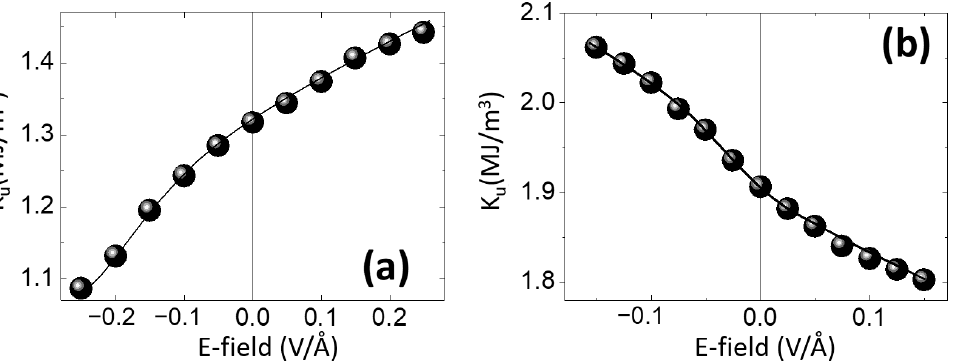
Figure 5. Opposite sign variation of the perpendicular magnetic anisotropy energy ( K u ) with an applied electric field (E-field) calculated for ( a ) V/Fe(5ML)/MgO and ( b ) Au/Fe(5ML)/MgO supercells- (adapted from [28]).